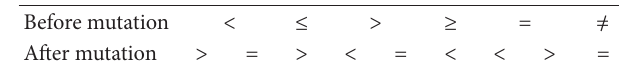
Figure 1: The framework of vulnerability testing. Table 1: RRF